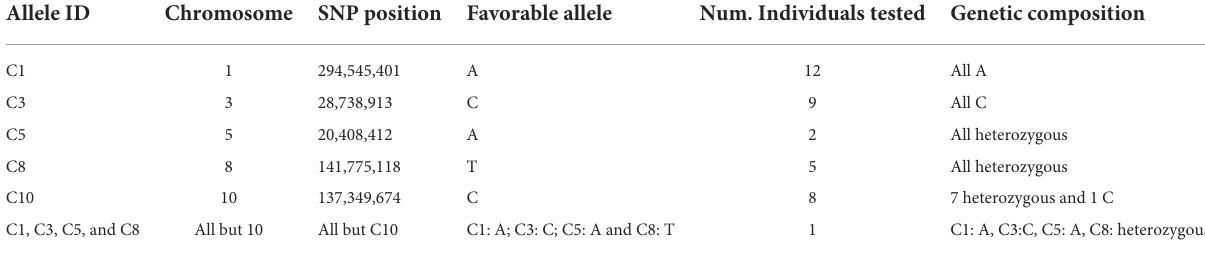
TABLE 2 Allelic composition of 2014 confirmation trial at five highly significant SNP locations identified in 2012 trial. Allele ID Chromosome SNP position Favorable allele Num. Individuals tested Genetic composition